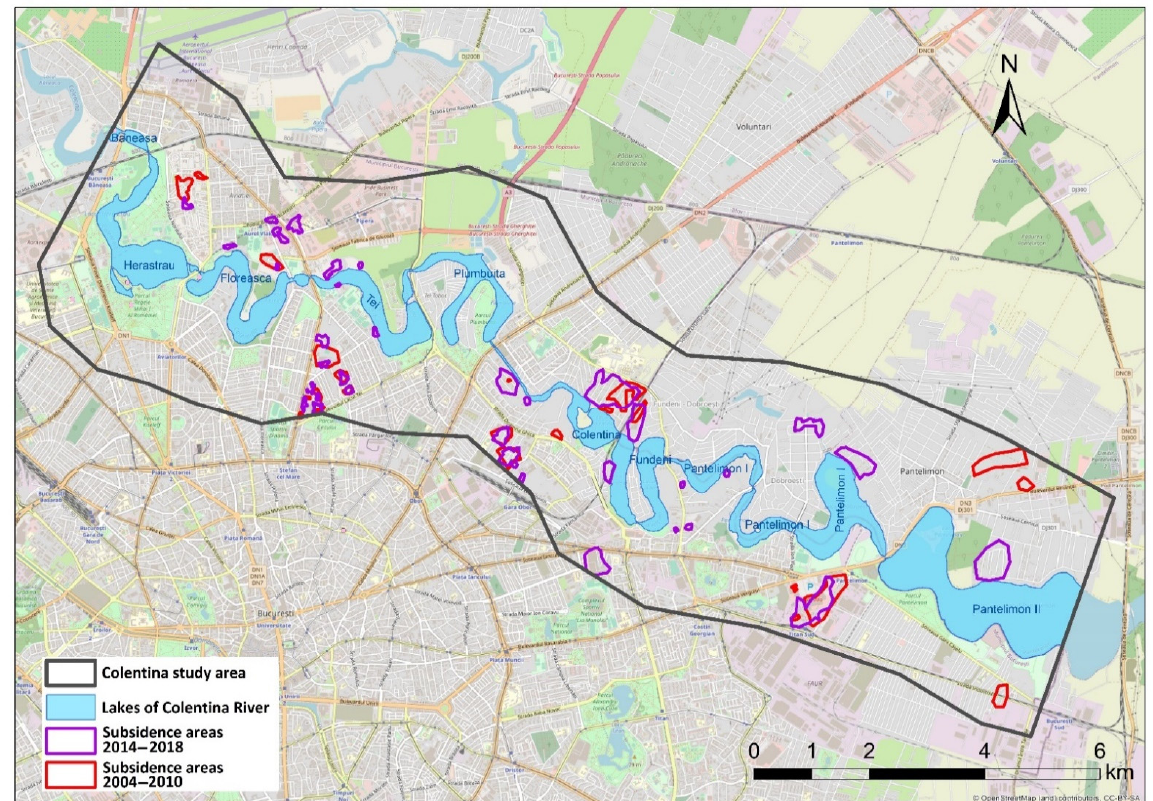
Figure 6. Subsidence areas in the Colentina River buffer zone, for the time intervals 2004–2010 and 2014–2018 [28]. Map generated in Esri ® ArcMap™ 10.3. Base map source: OpenStreetMap. Source: elaborated by the authors.